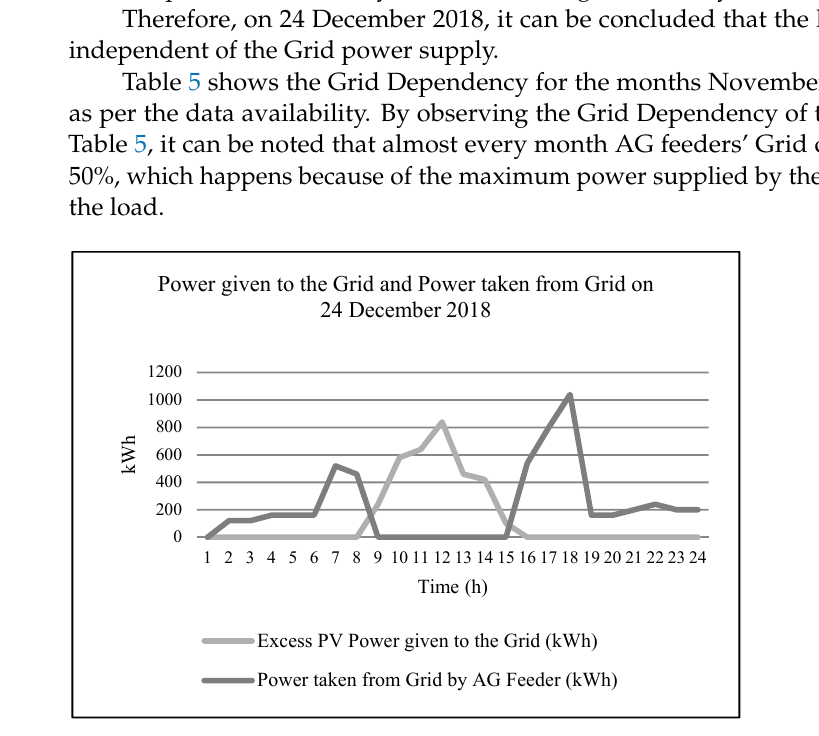
Figure 8. Power fed to the grid and power taken from grid.